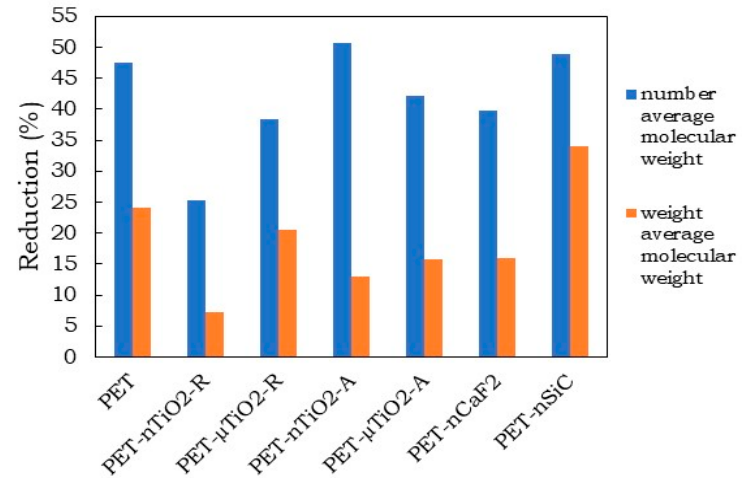
Figure 3. Molecular weight reduction after 170 days of exposure.